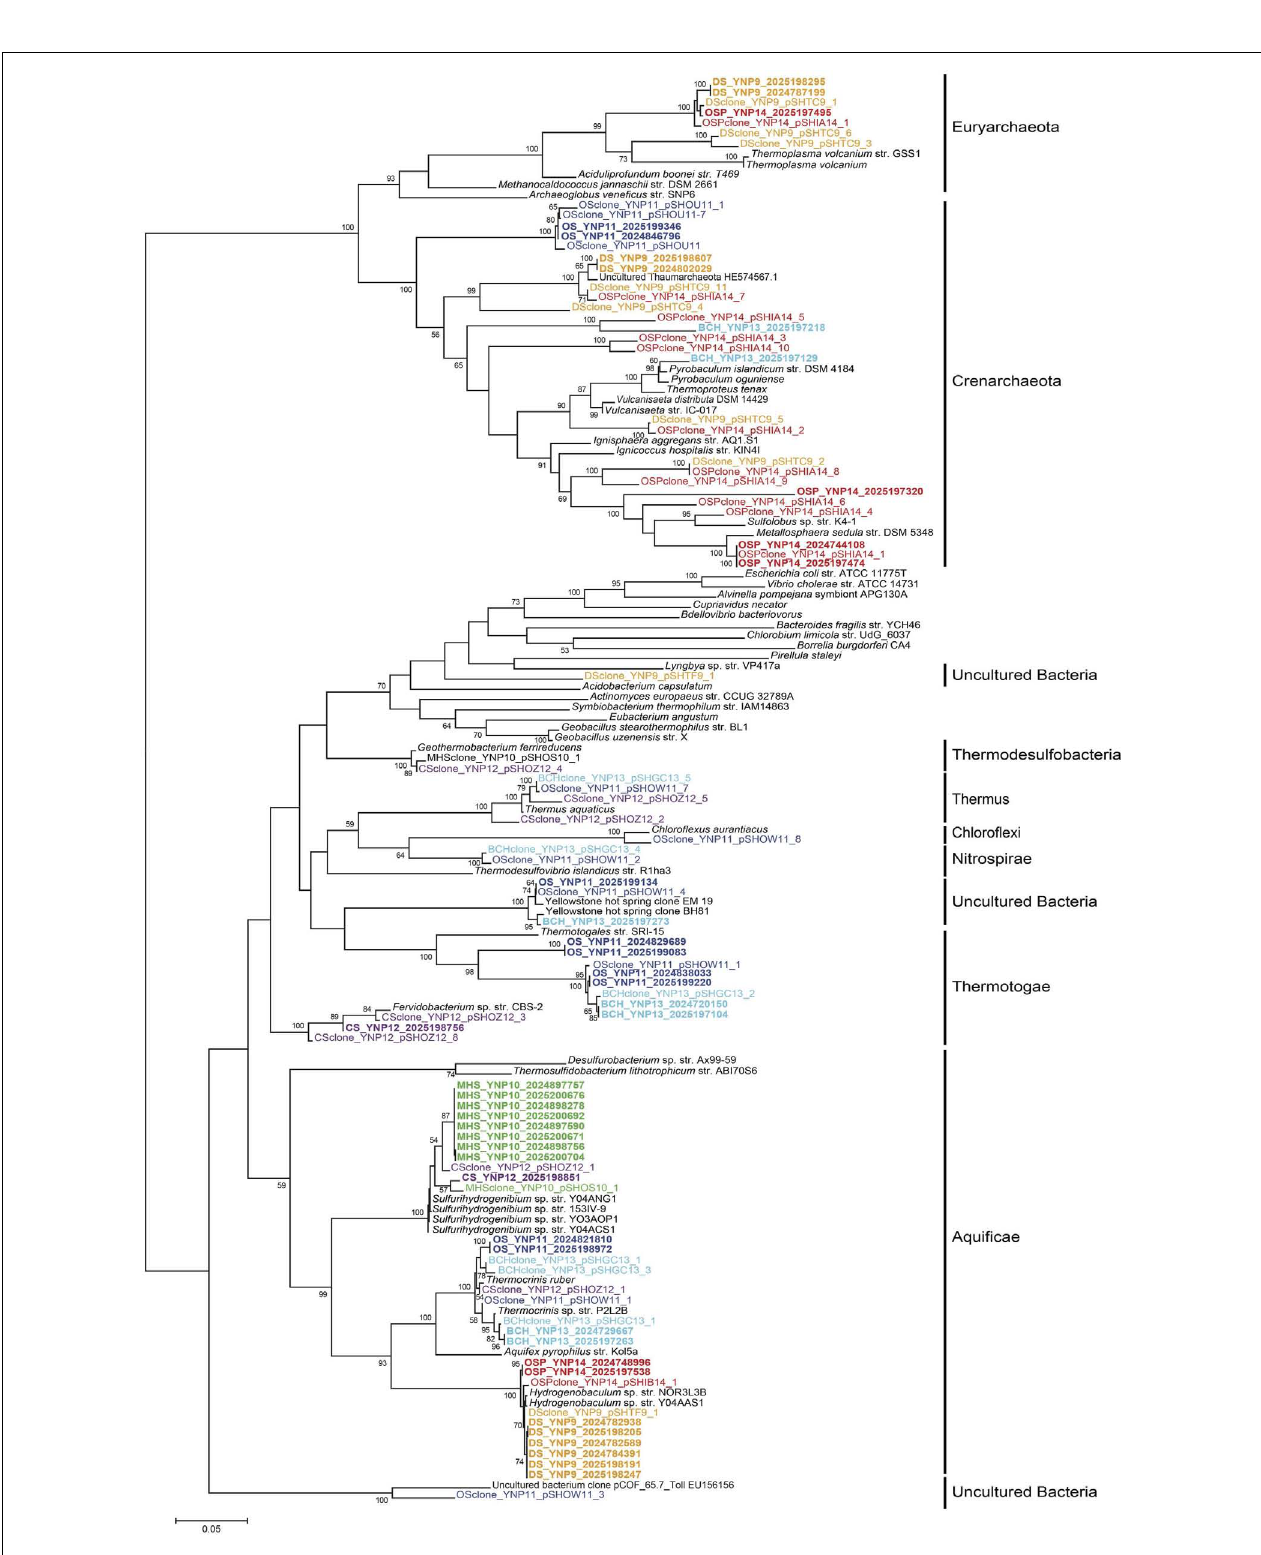
OSP_14 = red; MHS_10 = green; CS_12 = violet; OS_11 = dark-blue; BCH_13 = light-blue (core tree established using neighbor-joining methods with maximum-likelihood correction; metagenome entries added by